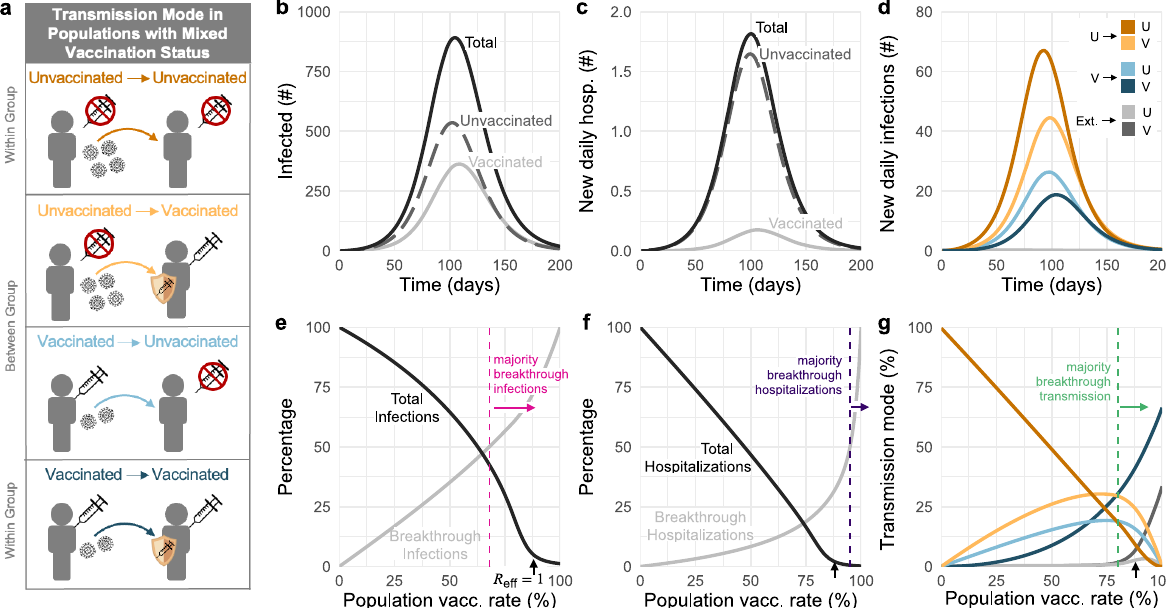
Fig. 1 Vaccination affects which population drives transmission and dominates infections and hospitalizations. a Diagram of four transmission modes within and between vaccinated and unvaccinated communities, where vaccines and prior infection decrease risks of infection, transmission, and hospitalization. b Number of infected individuals and c new daily hospitalizations over time (solid black), strati fi ed by unvaccinated (dashed gray) and vaccinated (solid gray) populations. d Daily transmission events separated and colored by transmission mode (see legend). e Cumulative infections and f hospitalizations as a percentage of total infections/hospitalizations without vaccination (black), and the percent of each accounted for by vaccine breakthroughs (gray) for varying vaccination rates. g Transmission mode (see legend) as a percentage of cumulative infections for varying vaccination rates. Black arrows in e – g indicate vaccination rate at which R eff = 1; vertical dashed lines indicate the lowest vaccination rates for which vaccinated individuals account for the majority of infections, hospitalizations, and transmission as annotated. R NPI ¼ 4 for all plots, with baseline VE 0 and immunity parameters vs. the delta variant (Materials and Methods, Supplementary Tables 1 and 2); no screening. b – d : 58% vaccination rate and 35% rate of prior